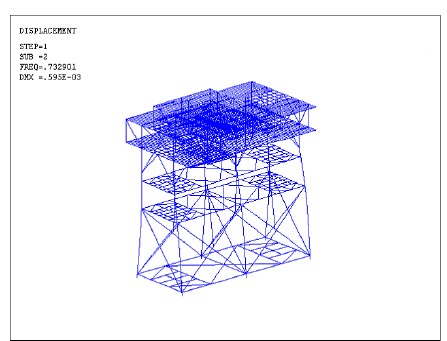
Figure 3. The first order natural frequency. Table 2. Comparisons of natural frequencies.